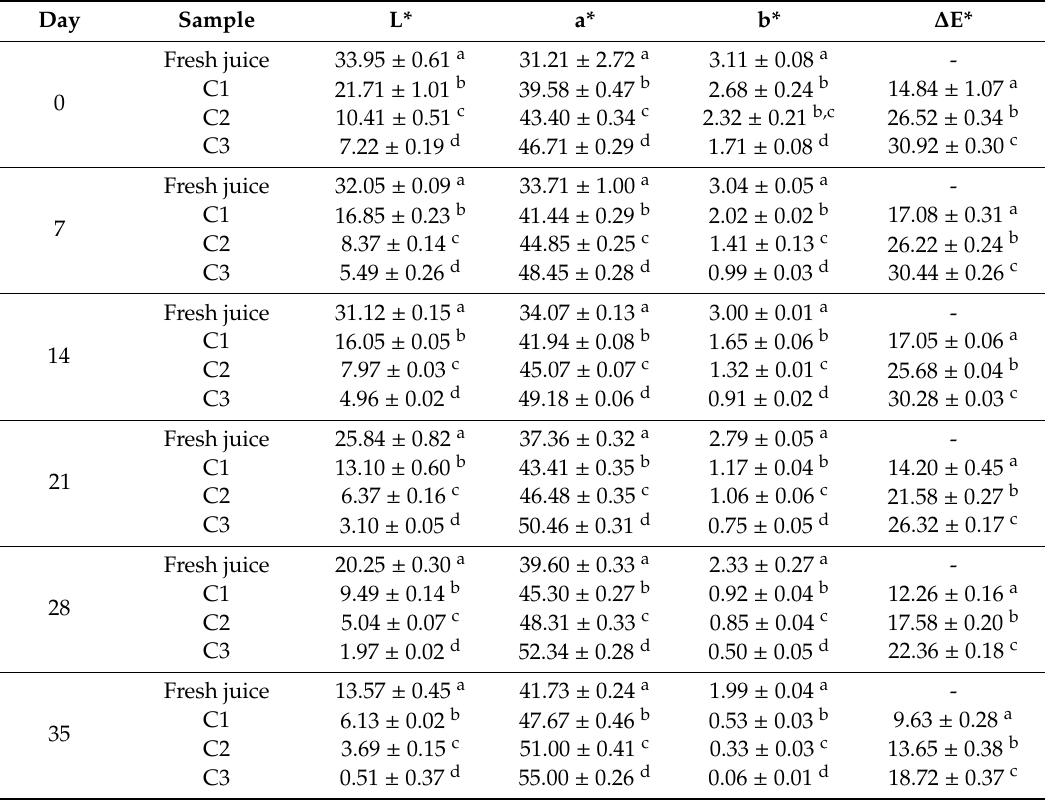
Di ff erent letters in the same column show significant di ff erences at 5% between homogeneous groups in each variable to a LSD. C1, C2 and C3 represents cycle 1, cycle 2 and cycle 3, respectively. “-” corresponds to a control sample on the day of